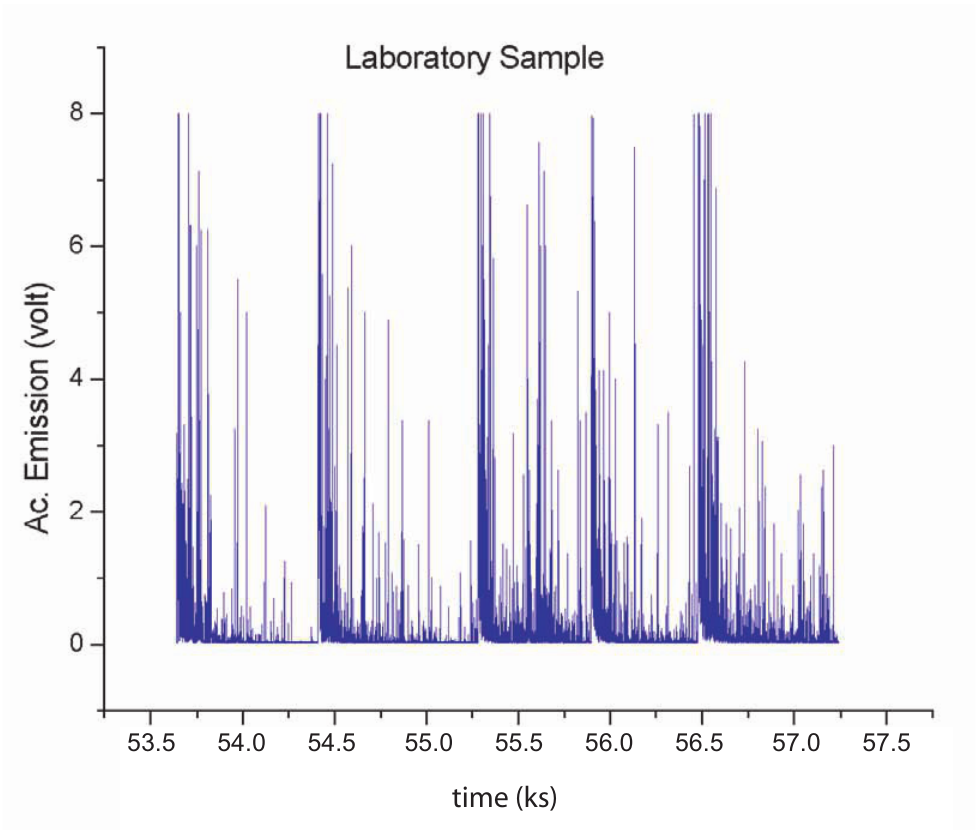
Fig. 2. AE bursts recorded during a laboratory experiment. A solid sample composed of a mix of Gran Sasso limestone was compressed and decompressed. The five stronger AE sequences correspond to increased stress. The highest peaks denote amplifier saturation level. The sampling rate is 200 ms. Redrawn after Petri et al. (1994) and Vespignani et al .